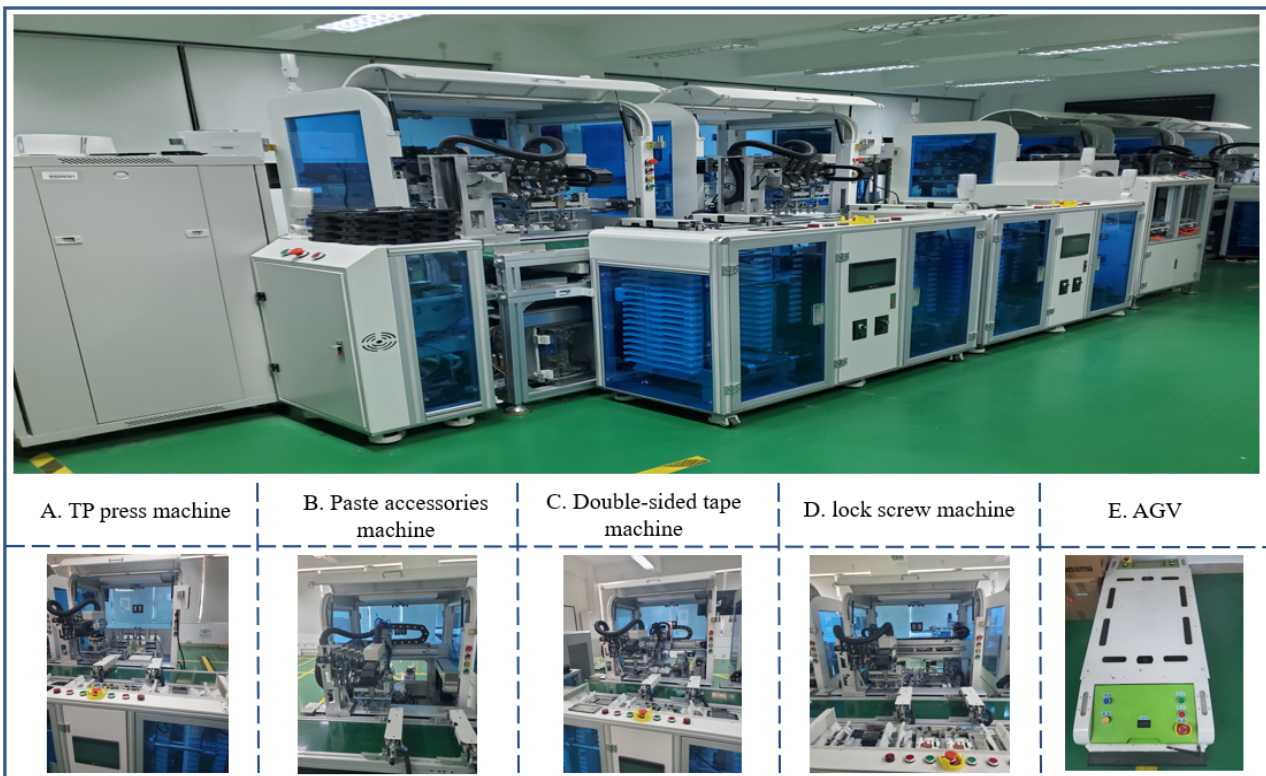
Figure 3. Virtual assembly line and its components.